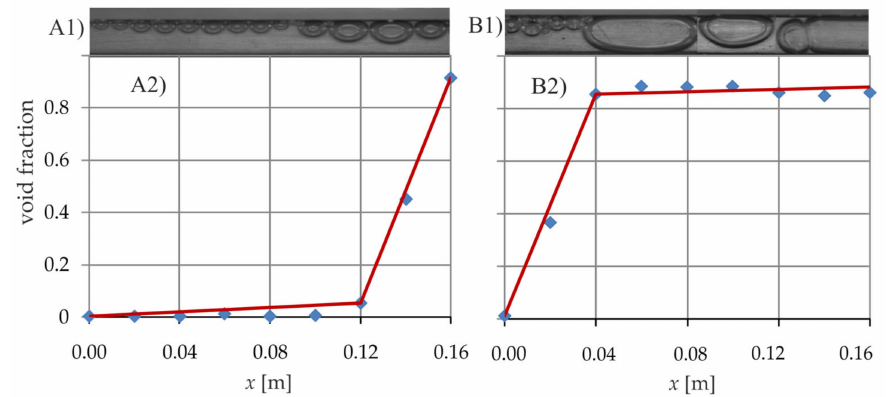
Figure 11. Examples of recorded flow structures presented in ( A1 ): q = 298.8 kW / m 2 , G = 8.6 kg / (m 2 s); ( B1 ): q = 223.2 kW / m 2 , G = 2.2 kg / (m 2 s). Corresponding void fractions (blue points), approximated with broken lines (red lines), are shown in ( A2 ) and ( B2 ).